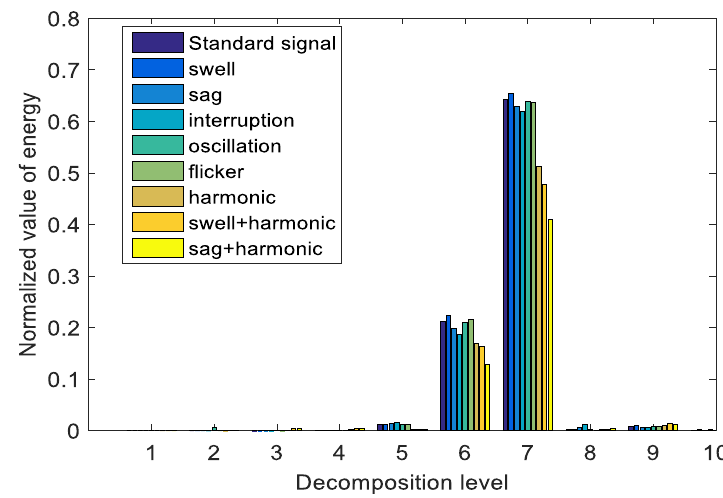
Fig. 1 Comparison of wavelet energy distribution of different power quality disturbance